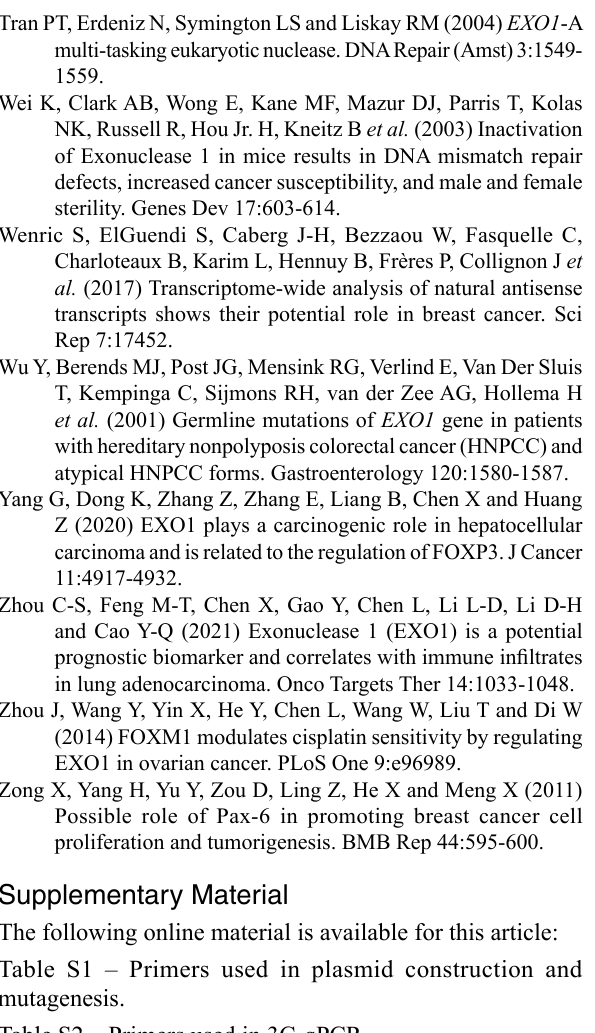
Figure S1- Relative enhancer activity for different alleles of rs4149909. Figure S2 – Histone modification for the region surrouding rs72755295 in breast cell. Figure S3 – The correlation between PAX6 and EXO1 expression in breast tissues. Figure S4 – Kaplan-Meier survival curves for BRCA patients grouped by EXO1 expression and